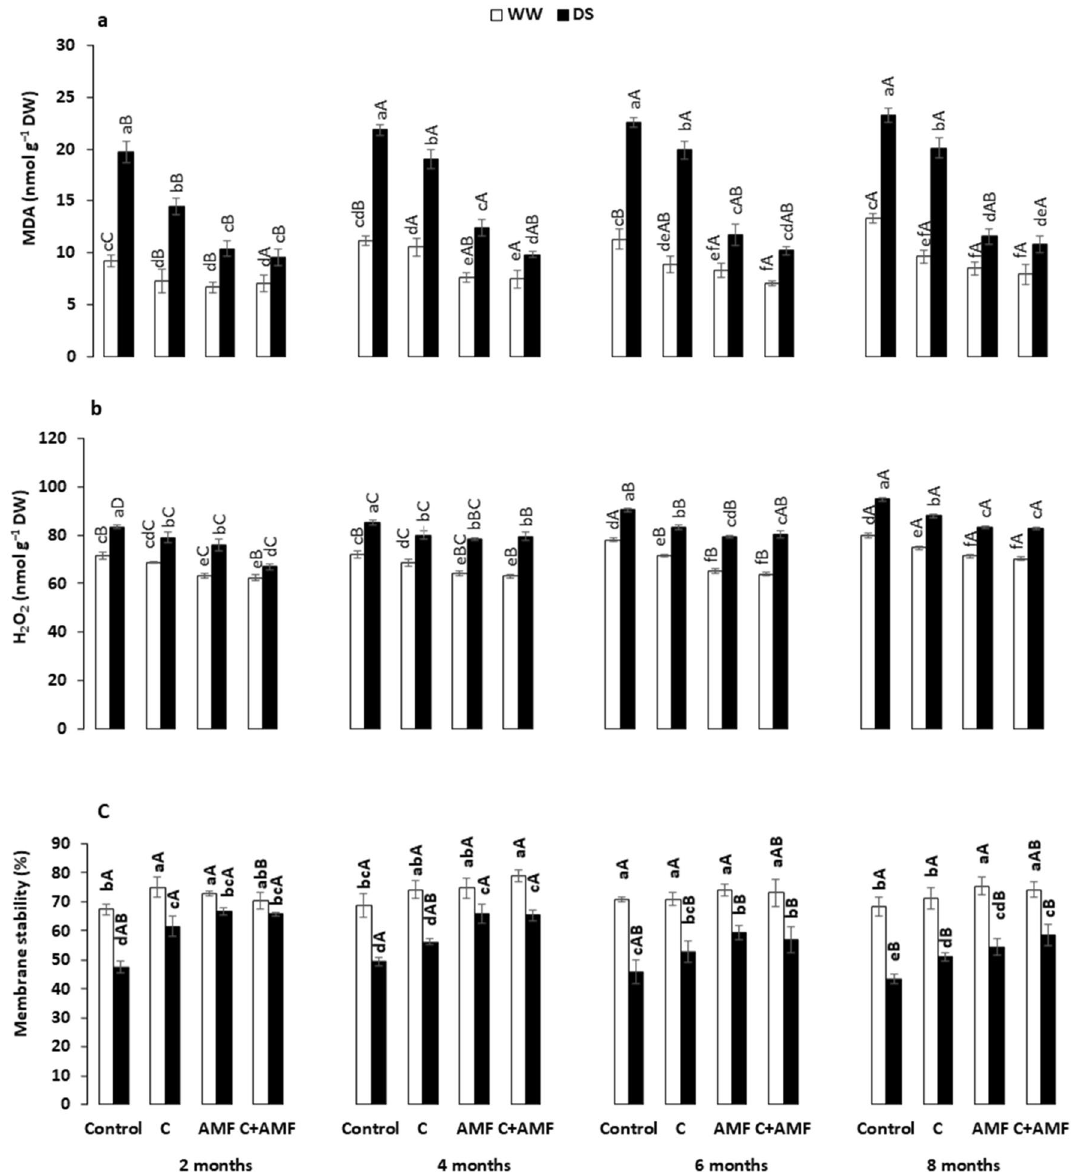
Figure 6. Effects of water regimes (WW: well-watered; open bars and DS: drought stress; filled bars) on ( a ) malondialdehyde; MDA, ( b ) hydrogen peroxide; H 2 O 2 and ( c ) membrane stability in control carob plants and plants amended with compost (C) and/or assemblage of indigenous arbuscular mycorrhizal fungi (AMF). Data are mean ± SE (n = 5). Means followed by the same letters within the same time point are not significantly different at P < 0.05 (Tukey’s HSD). The upper case represents the differences within WW or DS water regime, and the lower case represents the differences within a one-time